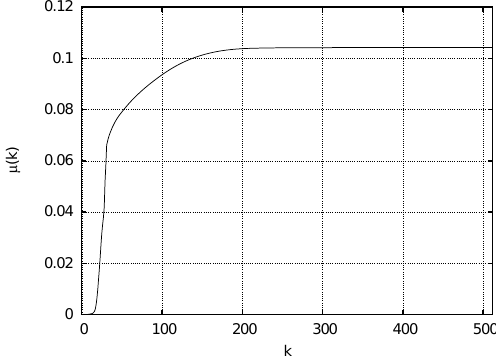
Figure 2. Steepness as a function of absolute value of wave number. Both the condensate and inverse cascade were suppressed.